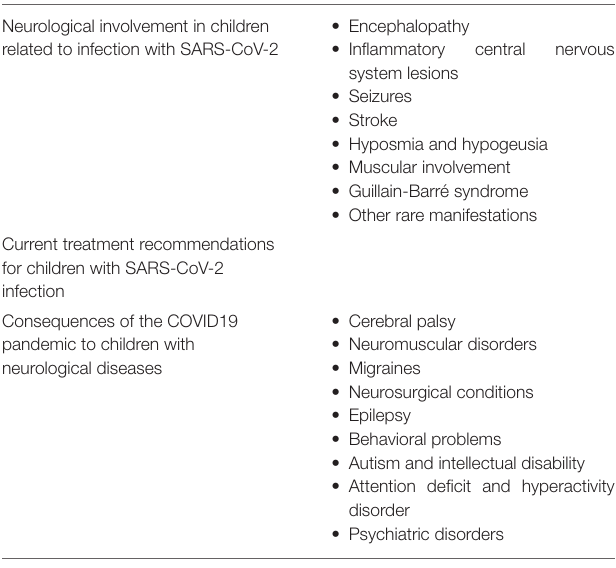
TABLE 1 | Summary. Neurological involvement in children related to infection with